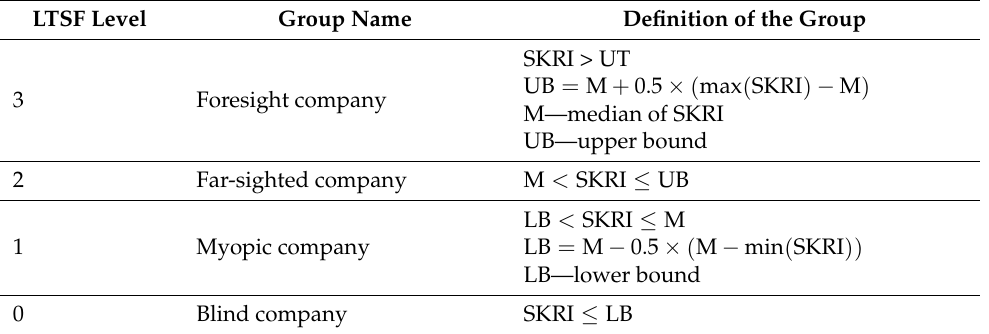
Table 2. Ranking of “strategic myopia” of the firm